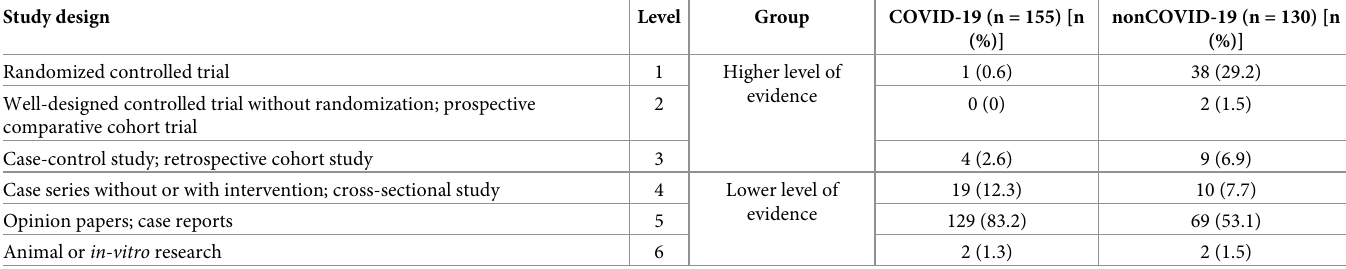
Table 1. Frequency distribution of the publications included on the levels of evidence pyramid [23,